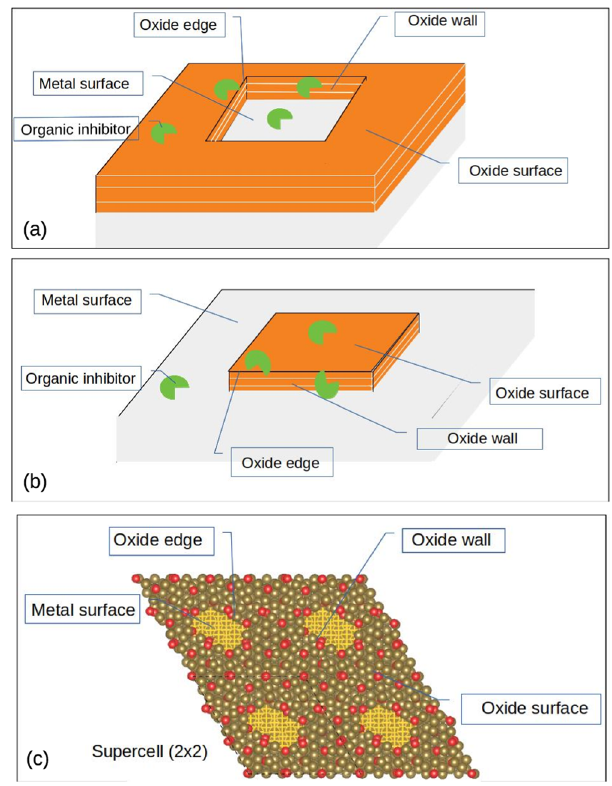
Fig. 1 Model of the partially oxide-covered copper surface. a Local depassivation. b Incomplete passivation. c Locally depassi- vated surface contains oxide and metal parts, oxide edges, and oxide walls, on which the organic inhibitor may adsorb